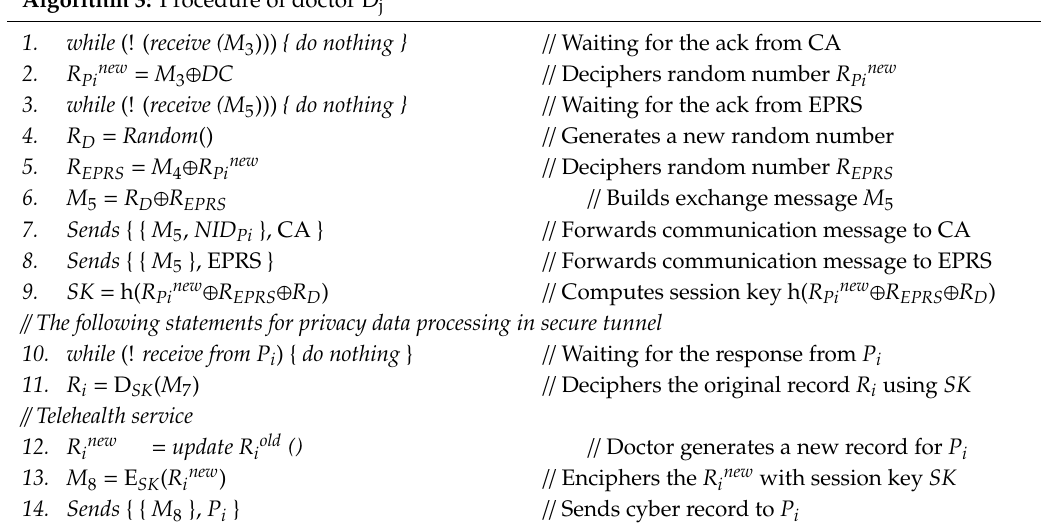
Algorithm 3: Procedure of doctor D